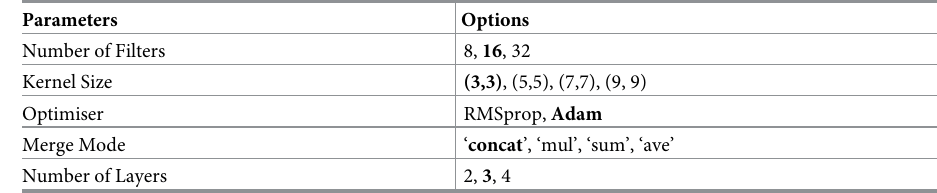
Table 4. Parameter optimisation with